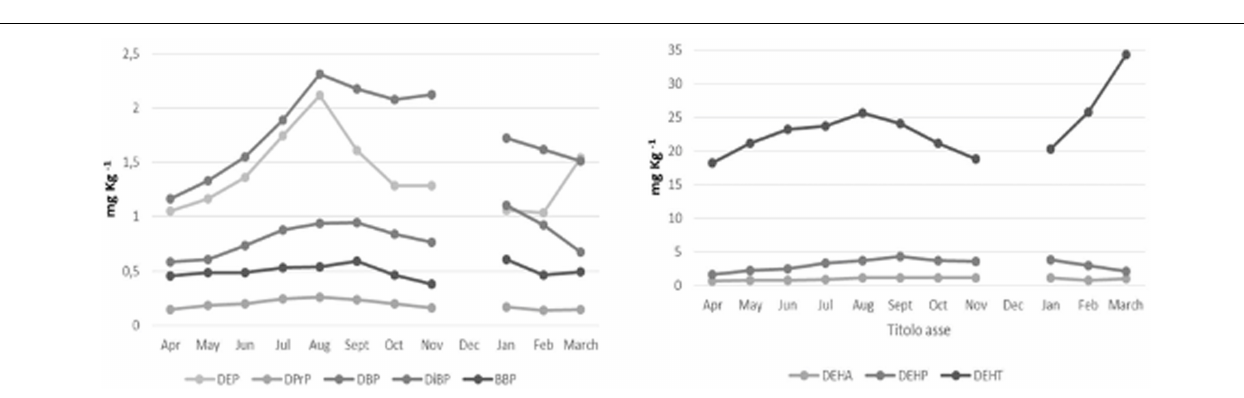
0.7 mg L − 1 and 1 mg L − 1 for DEHP and DBP in